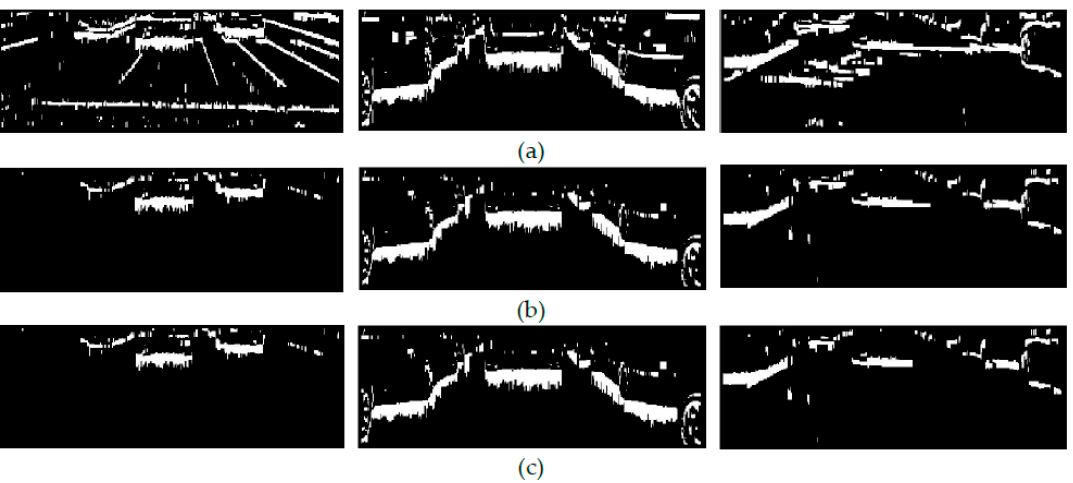
Figure 2. ( a ) Binary masks M ( x , y ) of Figure 1 after application of the saturation and intensity difference constraints, ( b ) M ( x , y ) after intensity thresholding and ( c ) M ( x , y ) after extraction of adjacent gradients due to lateral shadows.